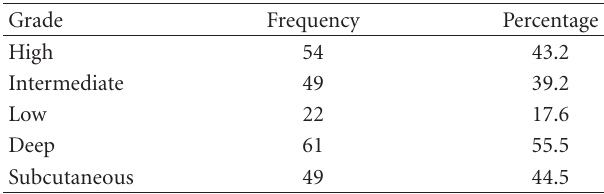
Table 2: Tumour grade and